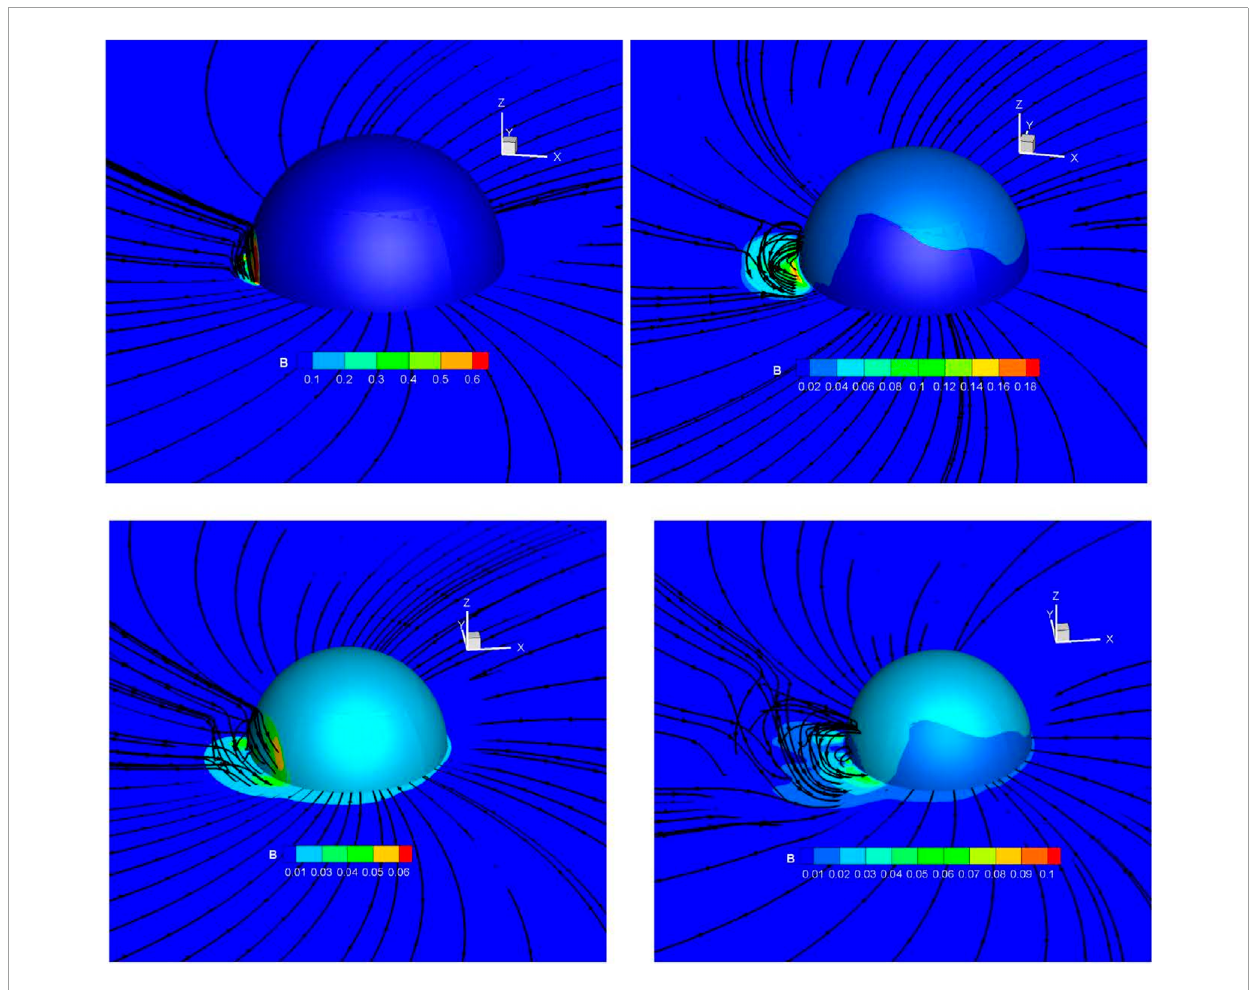
FIGURE 12 Three-dimensional view of the magnetic field for CASE-1 and CASE-2 at different times (Zhang et al., 2021).